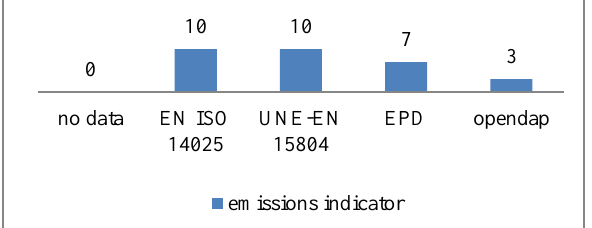
Figure 8. Ceramic category.